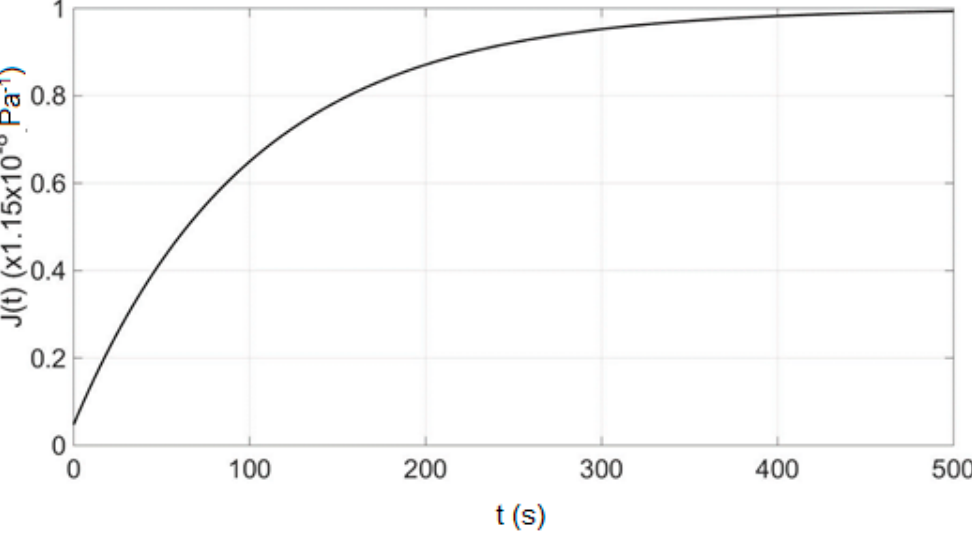
Figure 3. The variation of the creep compliance J ( t ) versus time.